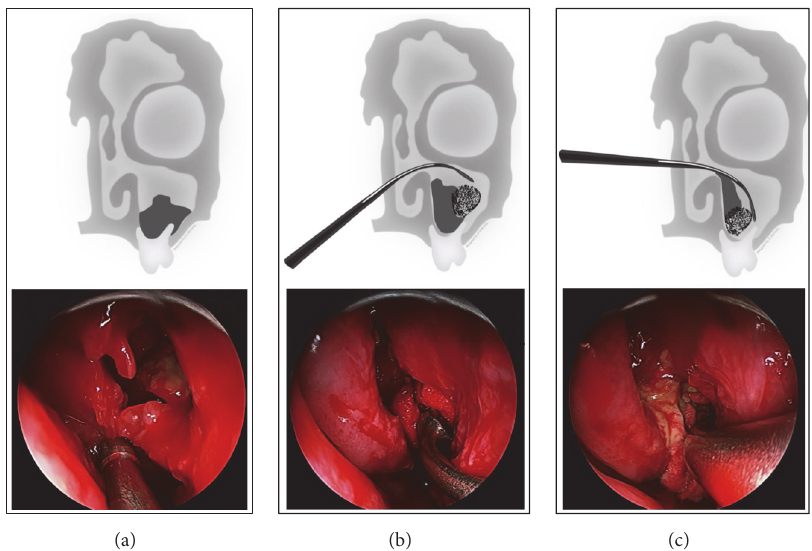
Figure 2: Important phases of intervention: (a) wide antrostomy; (b) introduction of the gauze in the maxillary sinus; (c) pushing the fungal material towards the middle meatus.